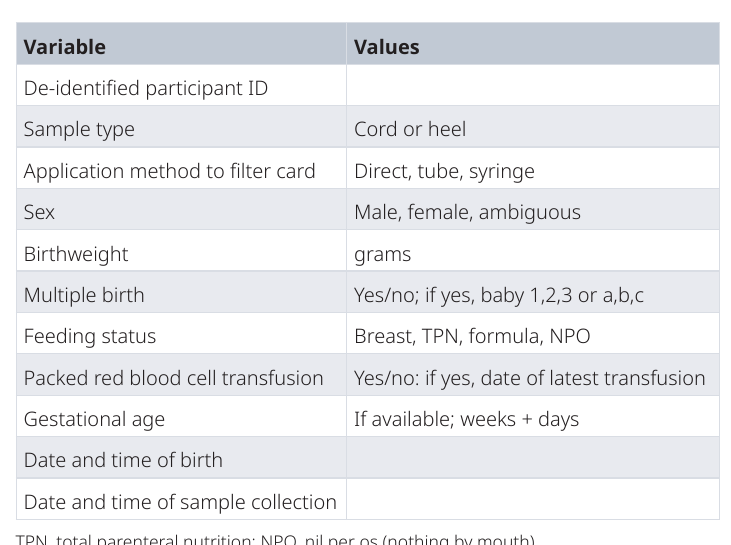
Table 1. Data variables required to support newborn screening